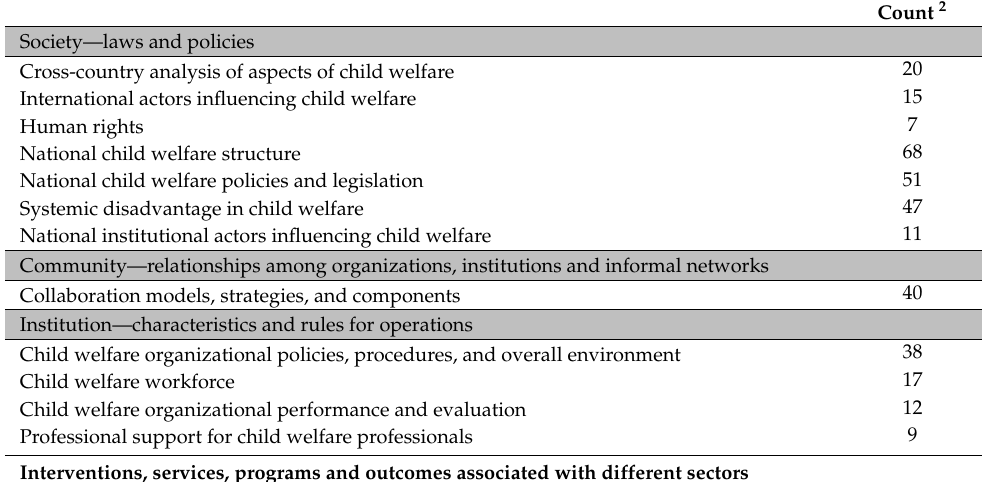
Table 5. Thematic Focus of Included Articles. 1